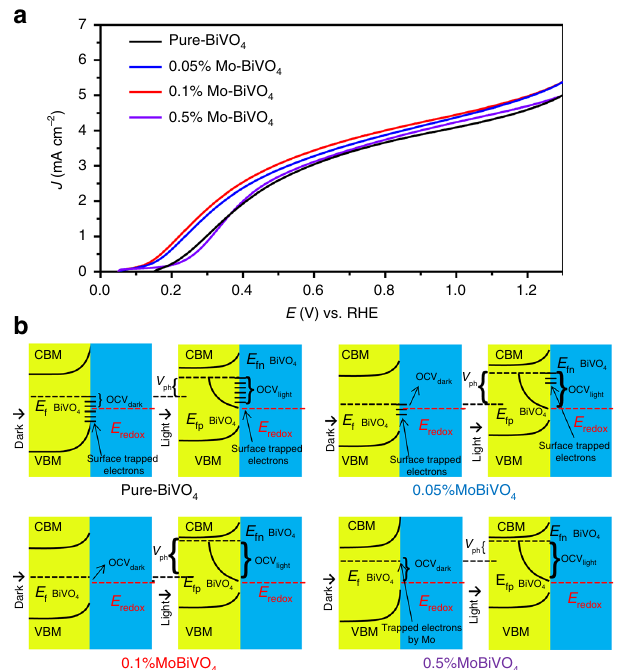
Fig. 2 Photoelectrochemical and photo-voltage characterization of the BiVO 4 -based photoanodes. a LSV curves of pure-BiVO 4 , 0.05% Mo-BiVO 4 , 0.1% Mo-BiVO 4 , and 0.5% Mo-BiVO 4 recorded at a scan rate of 25mVs − 1 under AM 1.5G one-sun irradiation in PPB solution with 0.5M Na 2 SO 3 as a hole scavenger (pH 7). b Band structures and band bending schematics